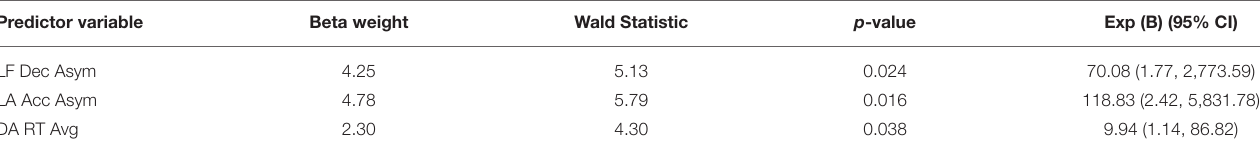
TABLE 3 | Logistic regression results for the final three, predictor, continuous variables. Predictor variable